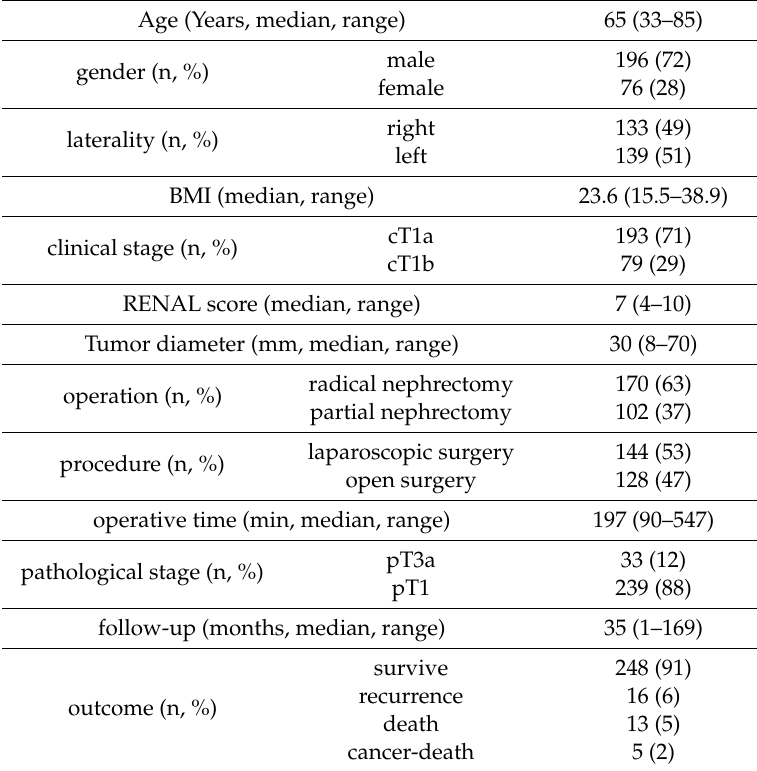
Table 1. Characteristics of the patients ( n =